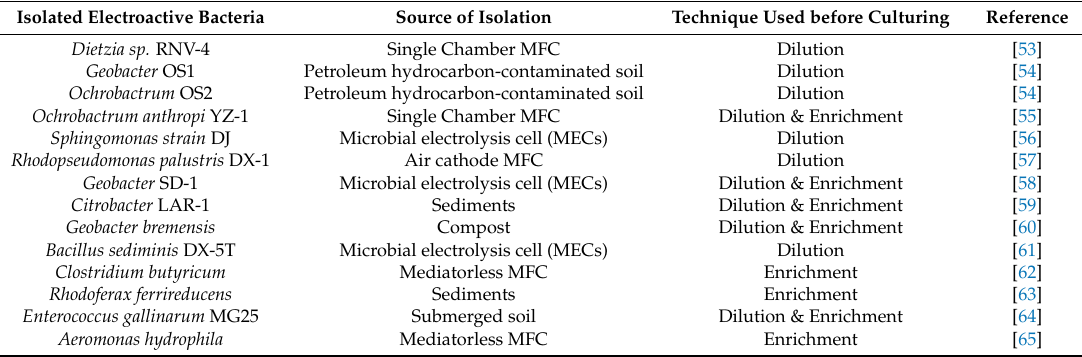
Table 2. Isolated electroactive bacteria from various bioelectrochemical systems. Isolated Electroactive